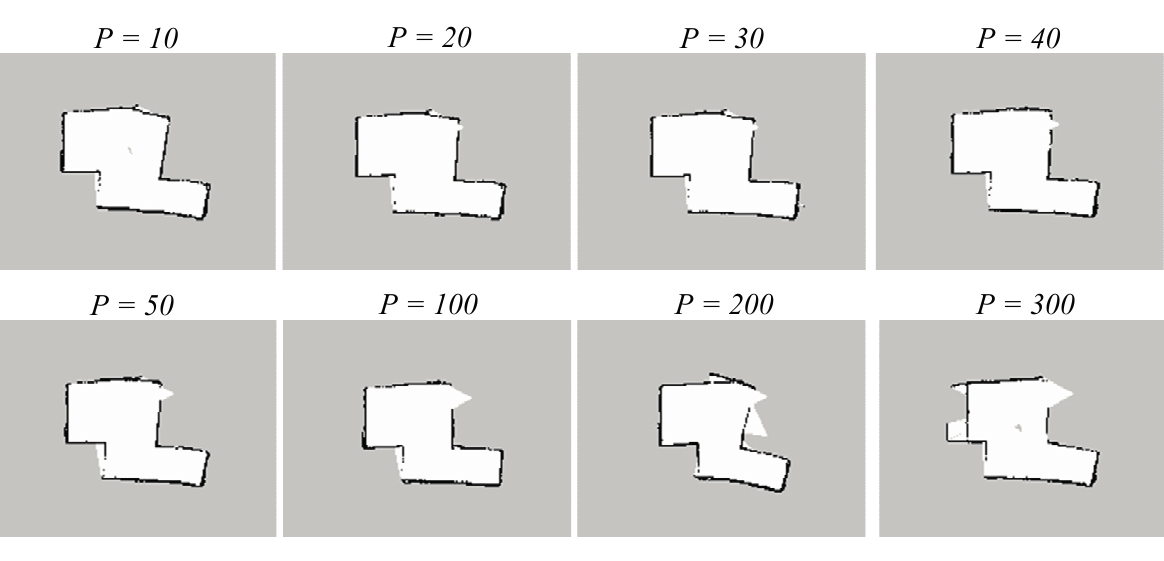
Figure 11. Room maps obtained using Gmapping technique with different number of